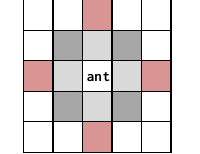
Figure 2. Increasing neighborhood once for each ant to 12